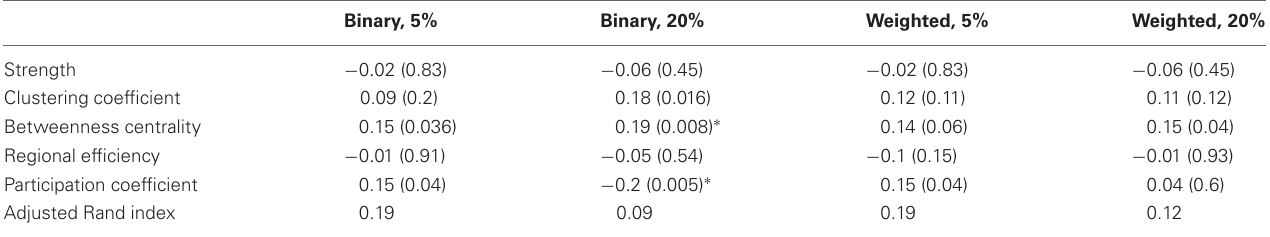
Table 2 | Correlation of nodal fcMRI and DTI graph theory measures across all 188 nodes for the NKI_fcmri_avg_GSR and NKI_dti_avg networks.